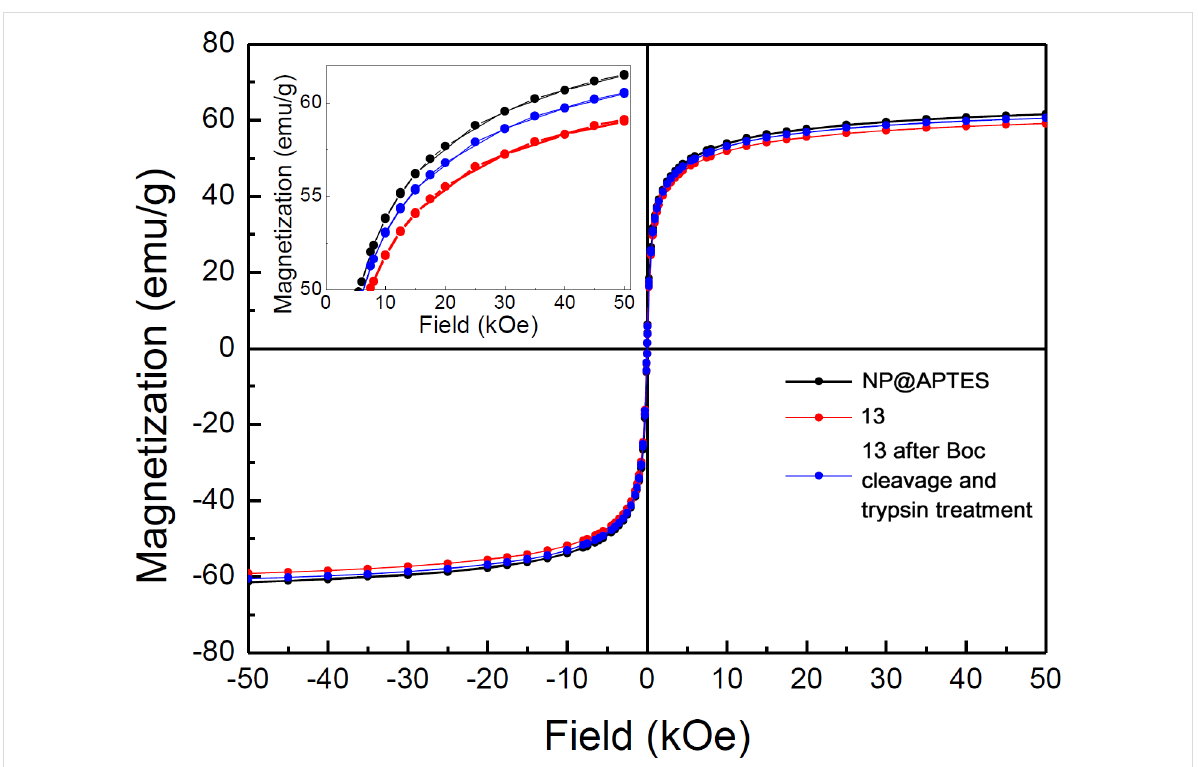
Figure 5: Room temperature magnetic hysteresis cycle for NP@APTES, the azelate conjugated nanoparticles ( 13 ) and 13 after Boc cleavage and trypsin treatment. In the inset the saturation magnetization in an enlarged scale is